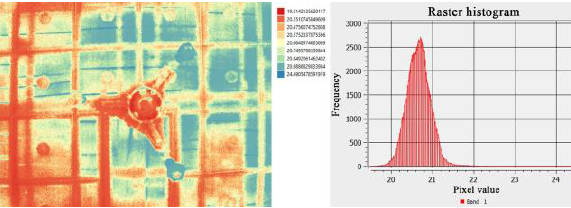
Figure 4. Example of exported thermal image with its histogram displayed in QGIS platform (temperature range from 19 °C to 24 °C).